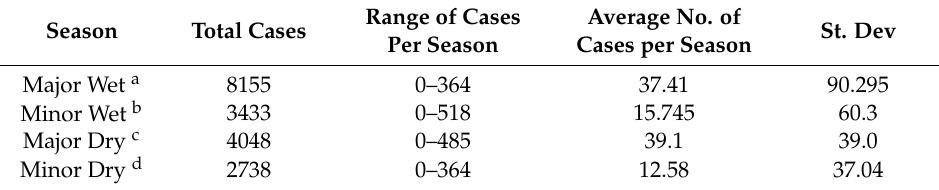
Table 2. Seasonal level total number of pediatric malaria cases during 2011 to 2012.